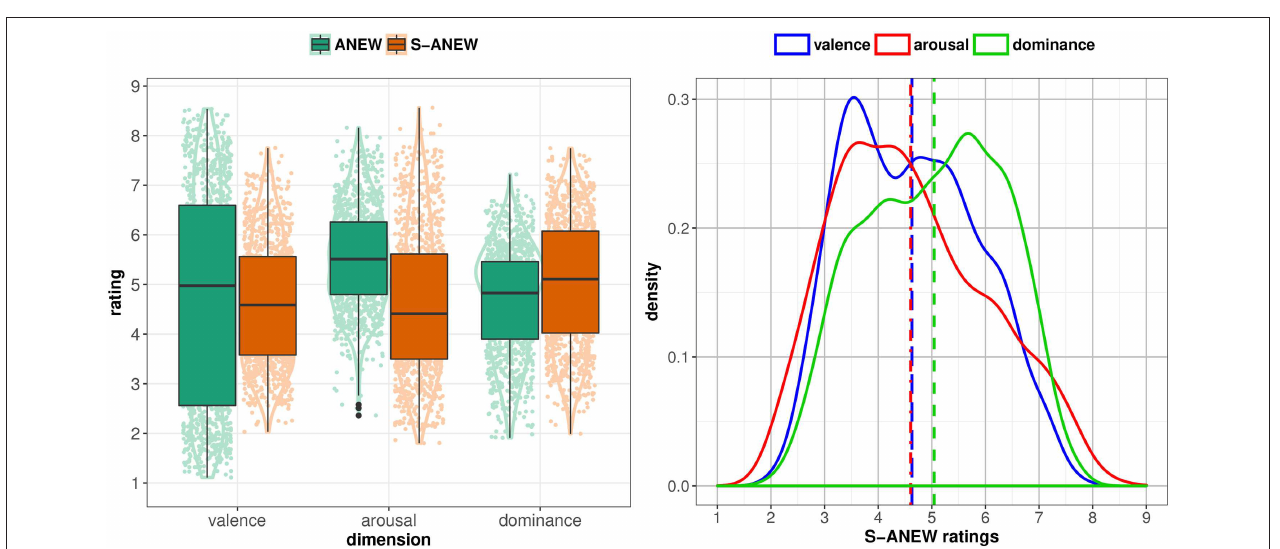
FIGURE 1 | (Left) Box plot representing valence, arousal and dominance ratings, classified by dataset. (Right) Spanish S-ANEW affective dimensions density of ratings. Plot bandwidth adjust set to 1.